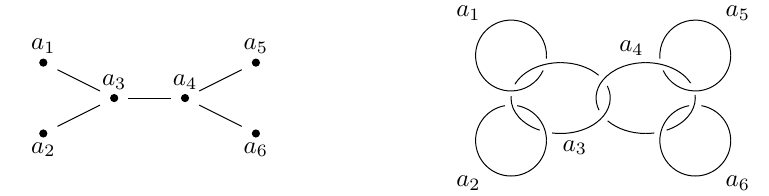
Figure 6 . A plumbing graph (left) and the associated surgery link (right).